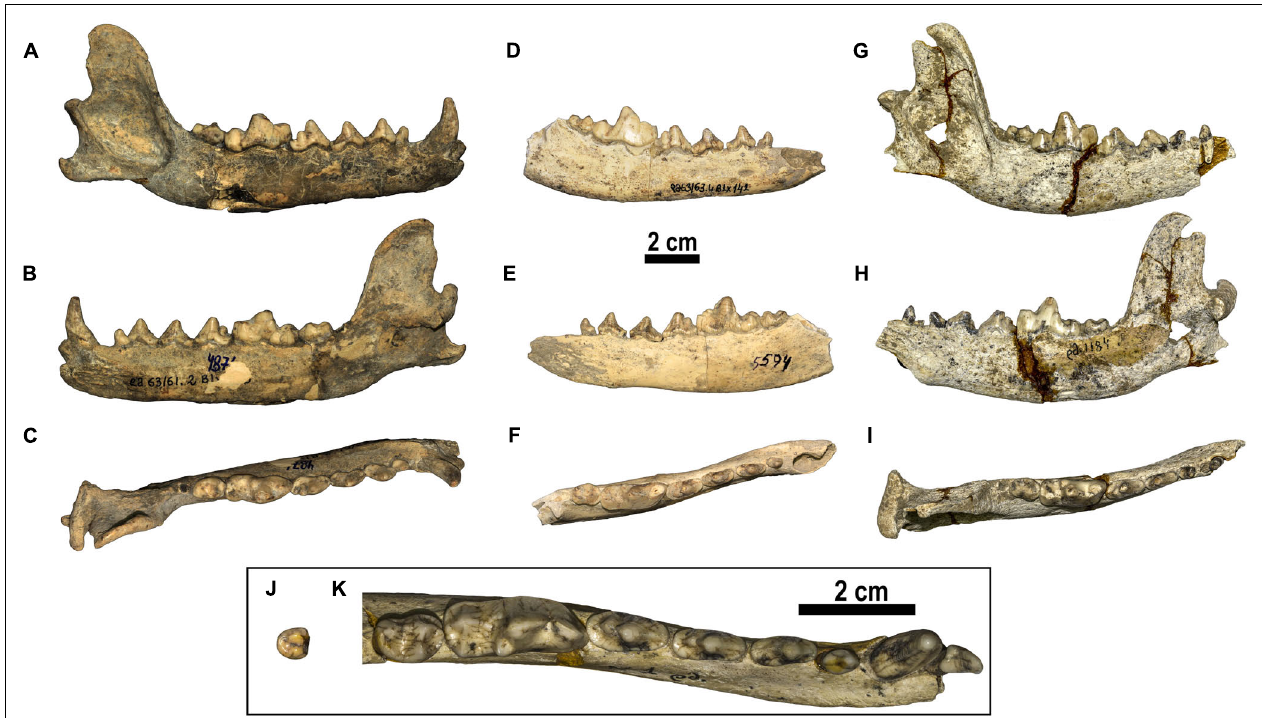
FIGURE 3 | Canis from Dmanisi. (A–C) D4871, right hemimandible in (A) buccal, (B) lingual, and (C) occlusal views. (D–F) D5594, right hemimandible in (D) buccal, (E) lingual, and (F) occlusal views. (G–I) D1184, right hemimandible in (G) buccal, (H) lingual, and (I) occlusal views. (J,K) Detailed occlusal morphology of the lower teeth of Canis from Dmanisi: (J) D372, left m3 ; and (K) D1, left